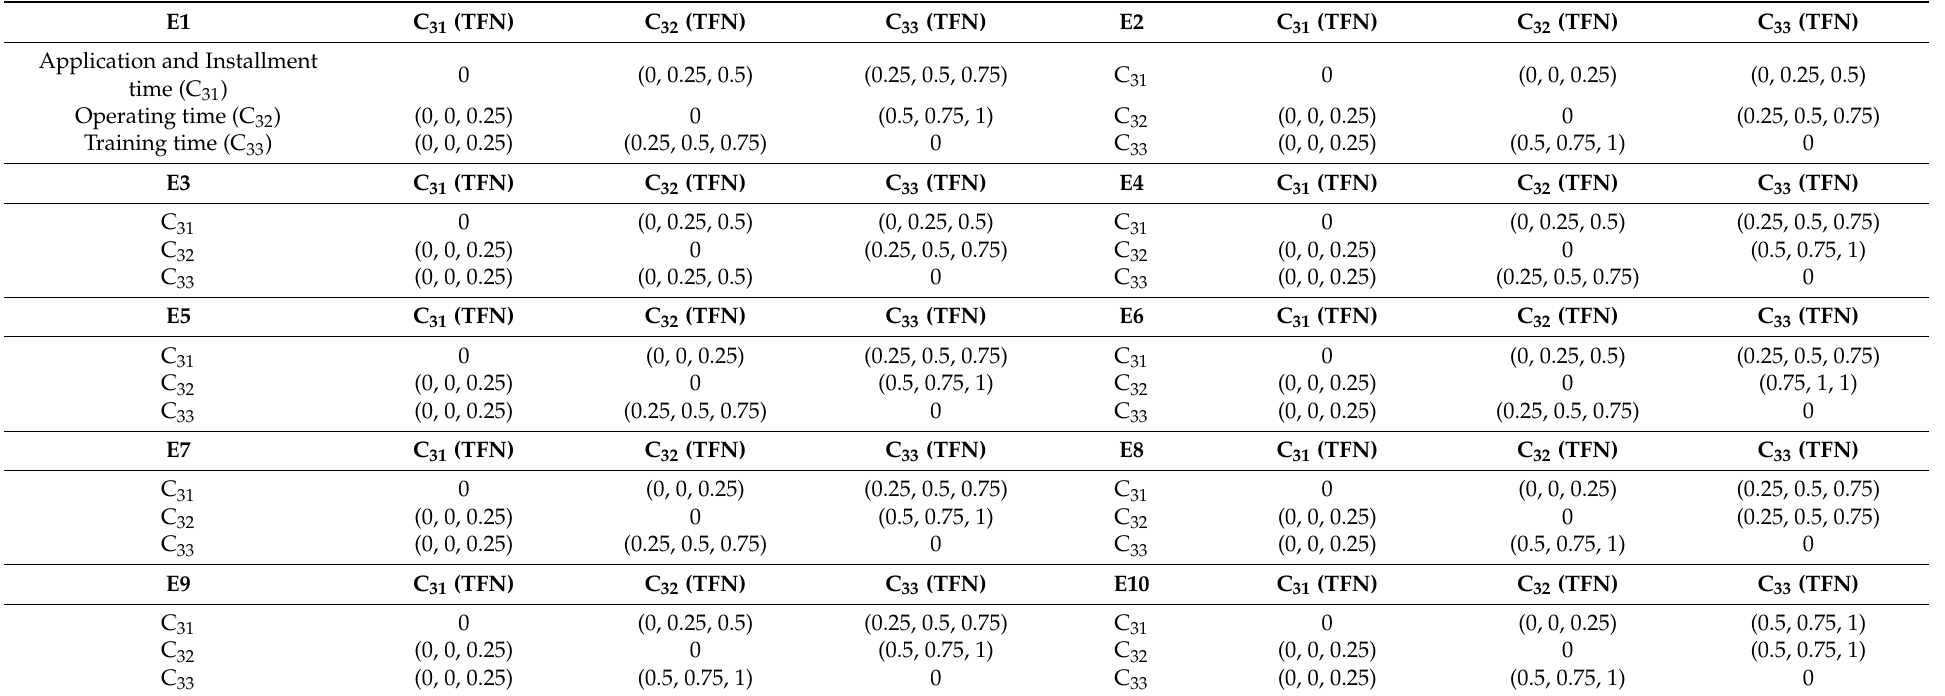
Table A9. The corresponding triangle fuzzy numbers in Table